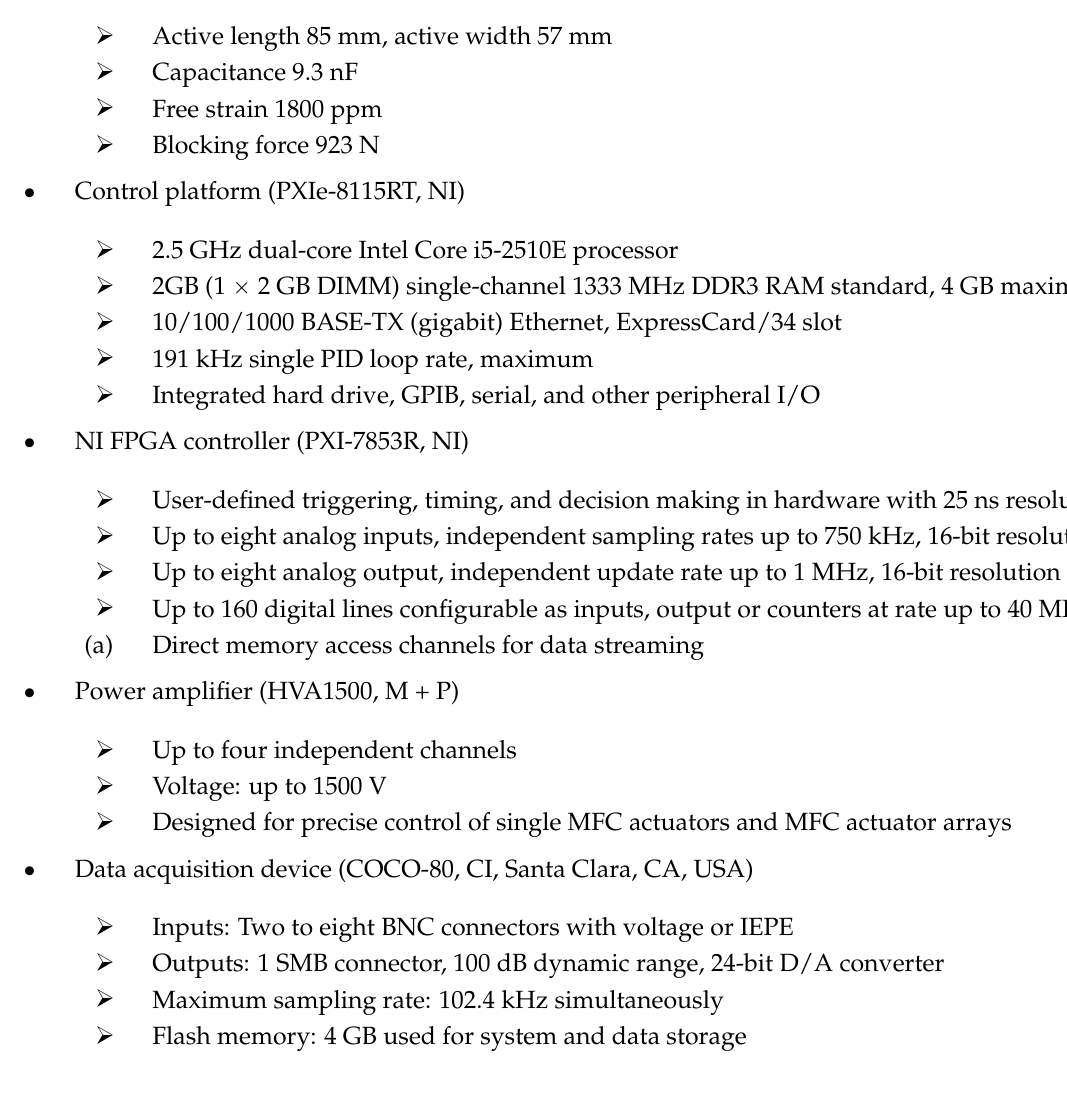
Figure 8. Set-up of the milling process experimental system.